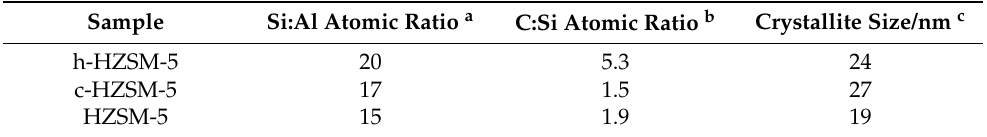
Table 1. Physical properties of zeolite HZSM-5 materials following hydrothermal syntheses in the presence or absence of HDTM.